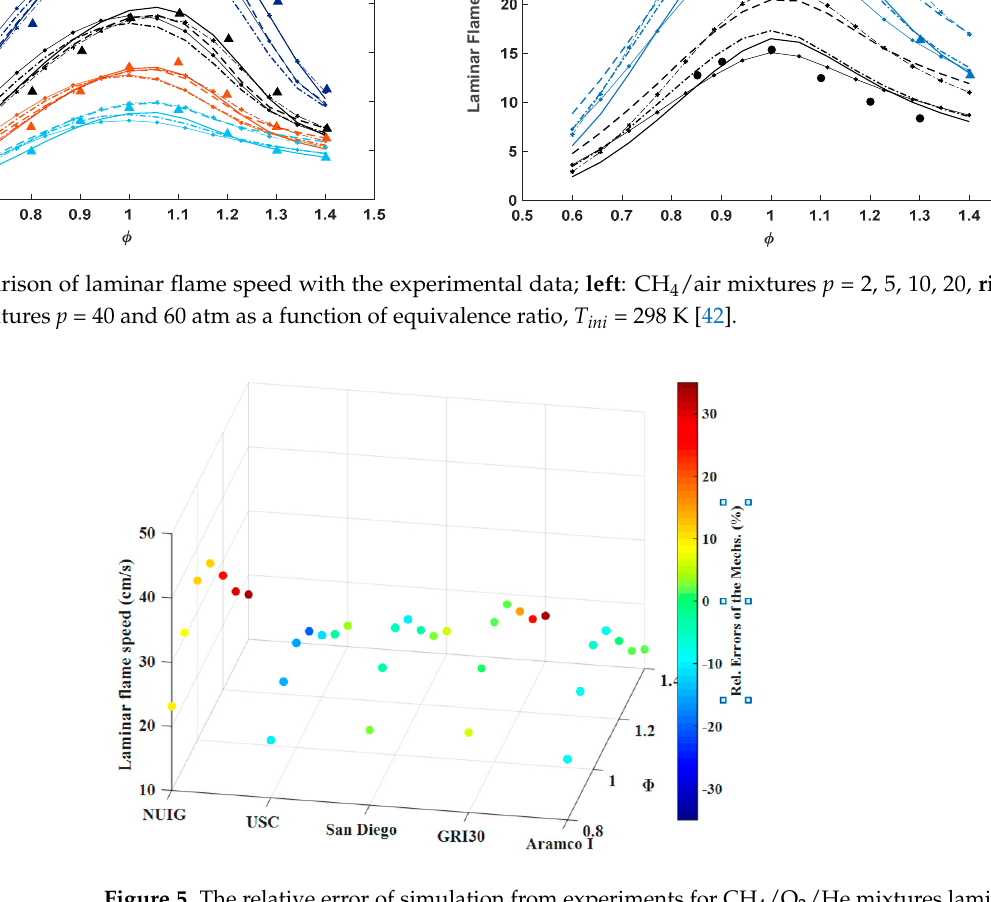
Figure 5. The relative error of simulation from experiments for CH 4 /O 2 /He mixtures laminar flame speed ( p = 40 bar, T = 298 K).